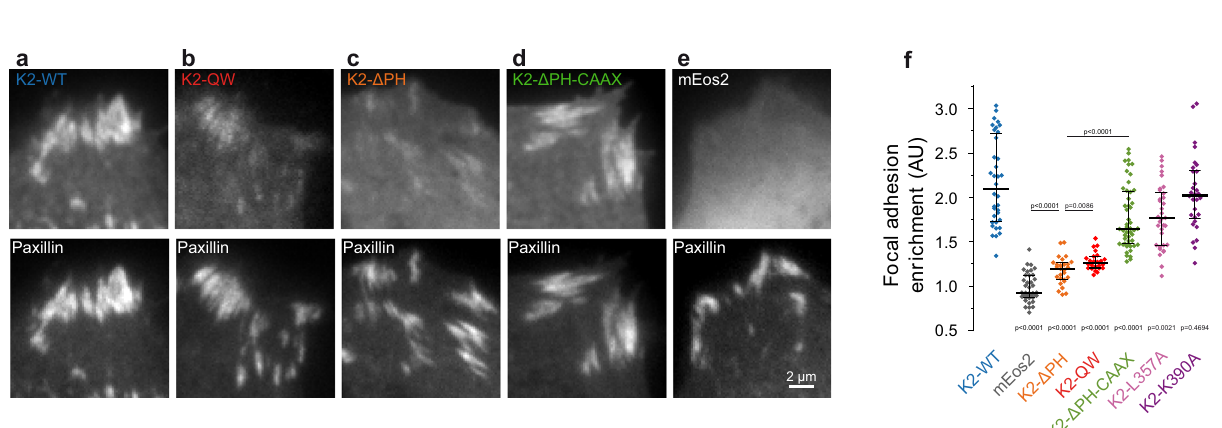
Fig. 5 Kindlin localization in the integrin signaling layer inside FAs depends on the PH domain. Top panel: Epi fl uorescence images of RFP-paxillin showing the localization of FAs. Bottom panel: 3D super-resolution images by DONALD displaying the axial localization of kindlin-2-WT ( a ), kindlin-2-QW ( b ), kindlin-2- Δ PH ( c ), paxillin ( d ) and kindlin-2- Δ PH-CAAX ( e ); scale bar, 3 µ m. For each pixel, the average axial localization of detected single molecules is color-coded. f Distributions of the single molecule axial localizations of kindlin-2-WT (blue) and paxillin (brown) inside (top) and outside FAs (bottom). Values represent the average of the distributions obtained from different cells. Positions of occurrence maxima (z peak ) were estimated by Gaussian fi tting. g Same as f , but with kindlin-2-WT (blue), kindlin-2-QW (red), kindlin-2- Δ PH (orange) and kindlin-2- Δ PH-CAAX (green). h Box plots displaying the median (notch) and mean (square) ± percentile (25 – 75%) of single molecule localizations inside (top) and outside FAs (bottom). Micrographs ( a – h ) correspond to a single experiment, but are representative of kindlin-2-WT: 6 cells, kindlin-2-QW: 9 cells, kindlin-2- Δ PH: 7 cells, paxillin: 6 cells, kindlin-2- Δ PH-CAAX: 7 cells. Where indicated, statistical signi fi cance was obtained using two ‐ tailed, non ‐ parametric Mann – Whitney rank sum test. The different conditions were compared to the mEos2 ‐ kindlin-2-WT condition. The exact P values are indicated on the fi gure except when P < 0.0001. Source data are provided as a Source Data fi le.